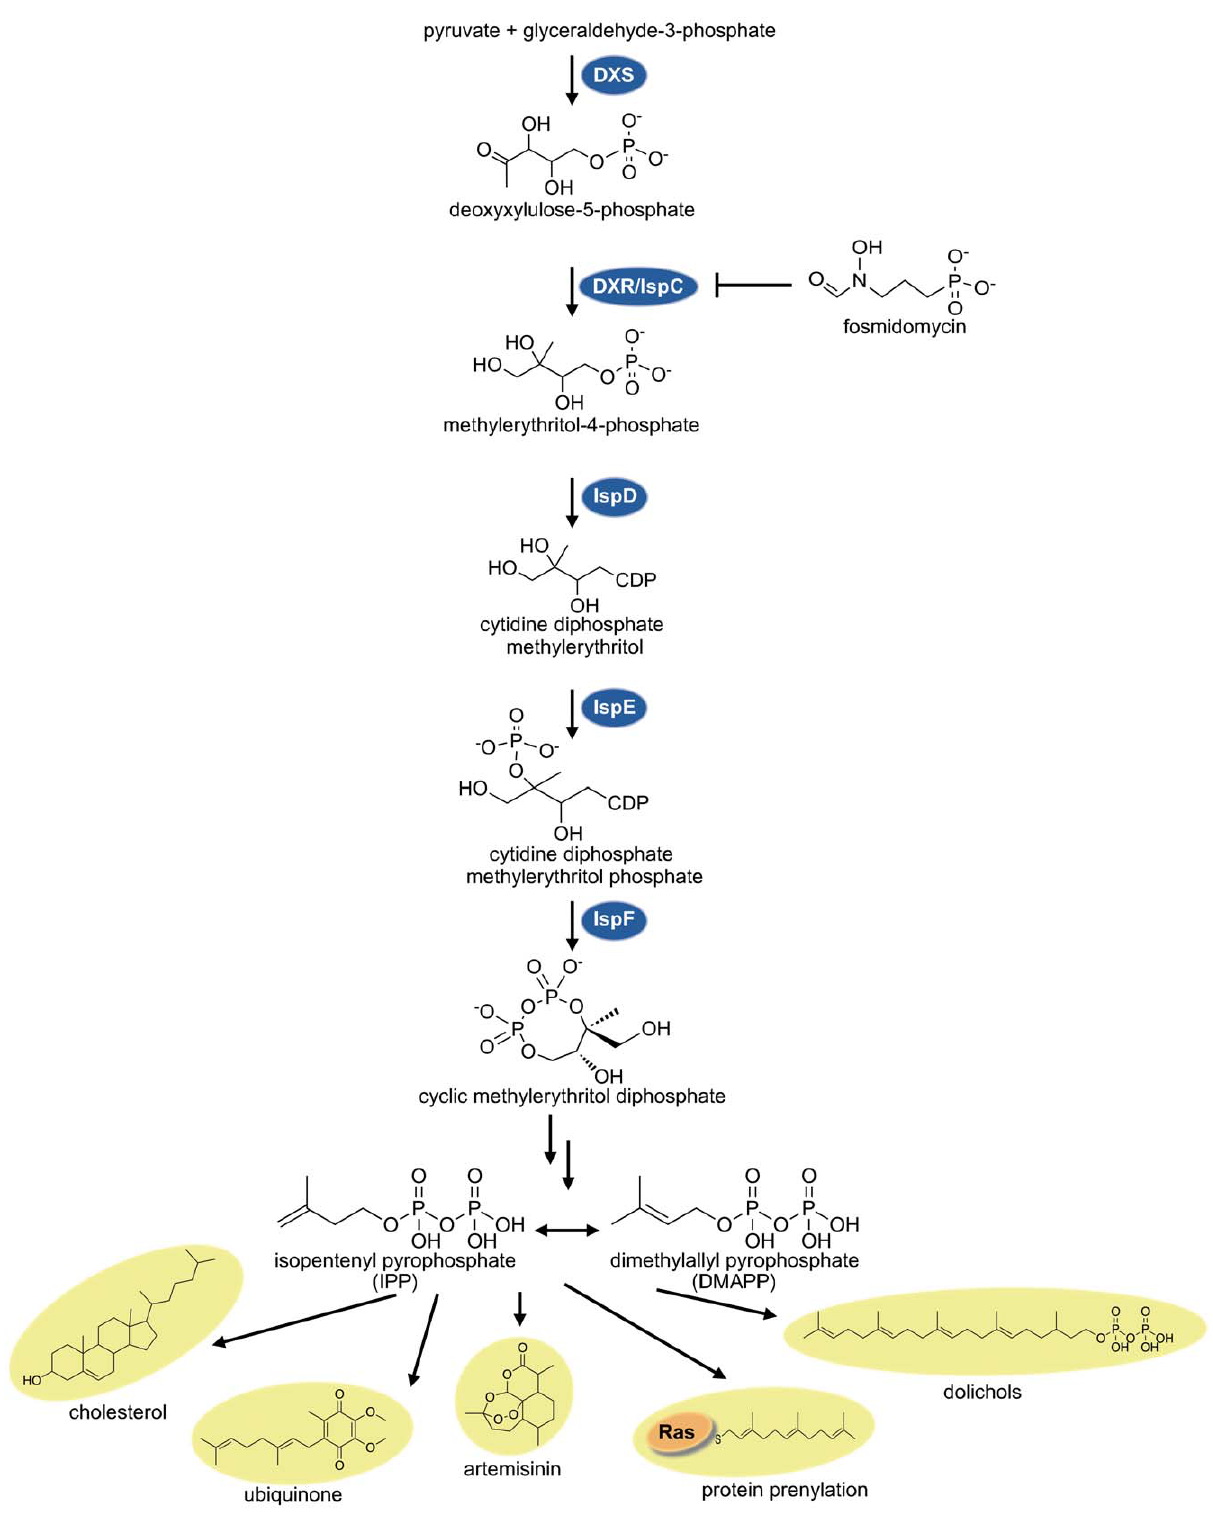
Figure 1. The non-mevalonate MEP pathway of isoprenoid biosynthesis. Isoprenoids are derived from the basic 5-carbon isoprenoid building blocks isopentenyl pyrophosphate (IPP) and its isomer, dimethylallyl pyrophosphate (DMAPP). In the MEP pathway, IPP and DMAPP are generated from pyruvate and glyceraldehyde 3-phosphate. Enzymes of this pathway are named here according to their E. coli homologs (DXR/IspC, IspD, IspE, and IspF). Fosmidomycin is a phosphonic acid antibiotic (PubChem compound ID 572) that inhibits a rate-limiting enzyme of this pathway (DXR/IspC) and blocks isoprenoid biosynthesis invivo.Isoprenoids havegreat diversityinstructure and cellular function—from plasma membranestability(cholesterol), electron transport (ubiquinone), and cell wall biosynthesis (dolichols) to protein modification (as prenyl groups) and secondary metabolites (such as artemisinin).